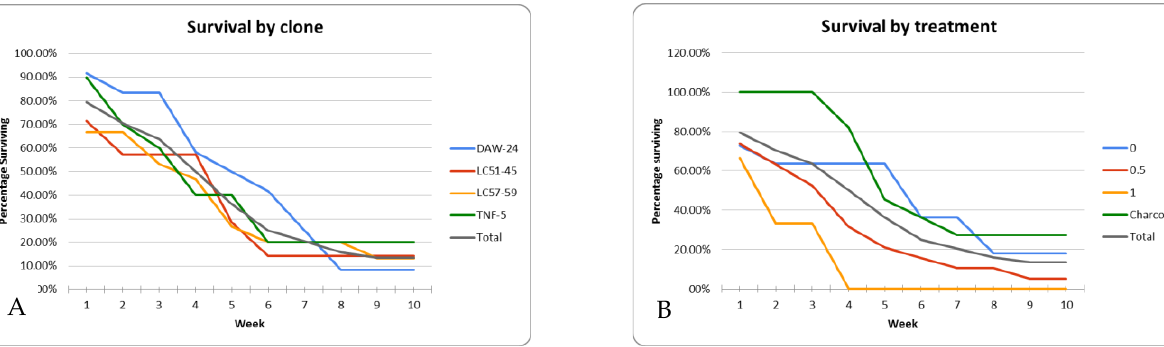
Figure 8. Xerophyllum asphodeloides micropropagated shoot survival over time after in vitro rooting treatments and shoots from four clones planted in greenhouse soil. ( A ) Survival by clone. ( B ) Survival by in vitro rooting treatment.